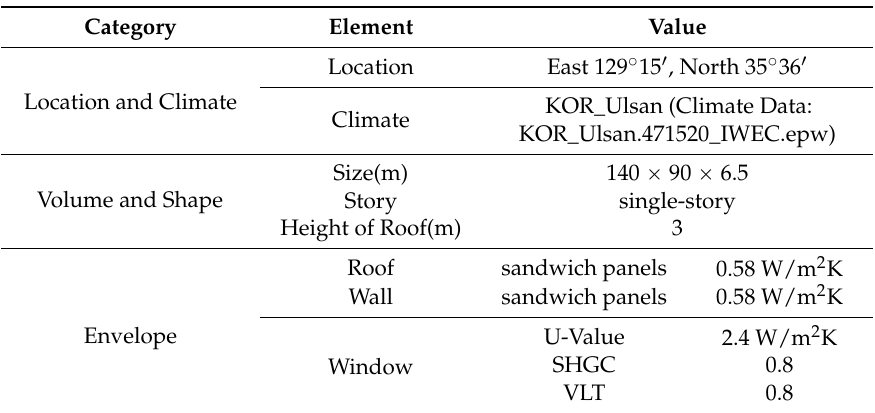
Table 1. Description of Industrial Building.